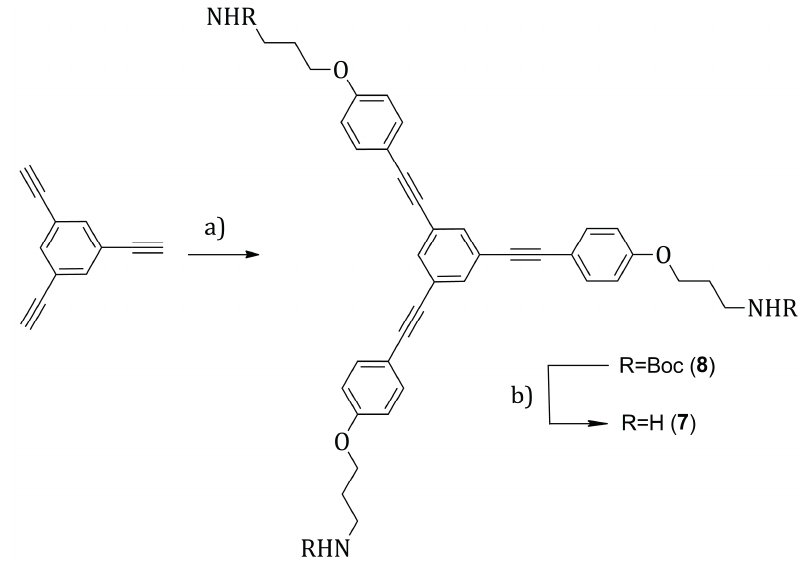
Scheme 8. Synthesis of the precursor 7 : ( a ) 9 , Pd(PPh 3 ) 2 Cl 2 (6%), CuI (2.3%), dry